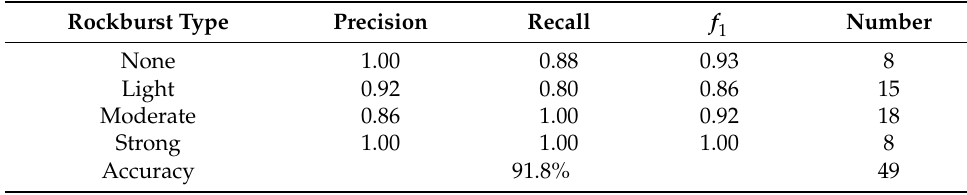
Table 10. The testing performance of DF models with Tr (85%)-Te (15%).